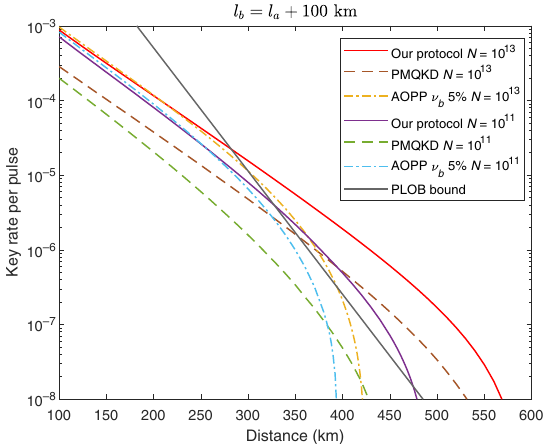
FIG. 10. Comparison of secret key rates of our protocol with arbitrary time matching, PMQKD, and AOPP versus transmis- sion distance in asymmetric channels. Our protocol exhibits a decent performance in asymmetric